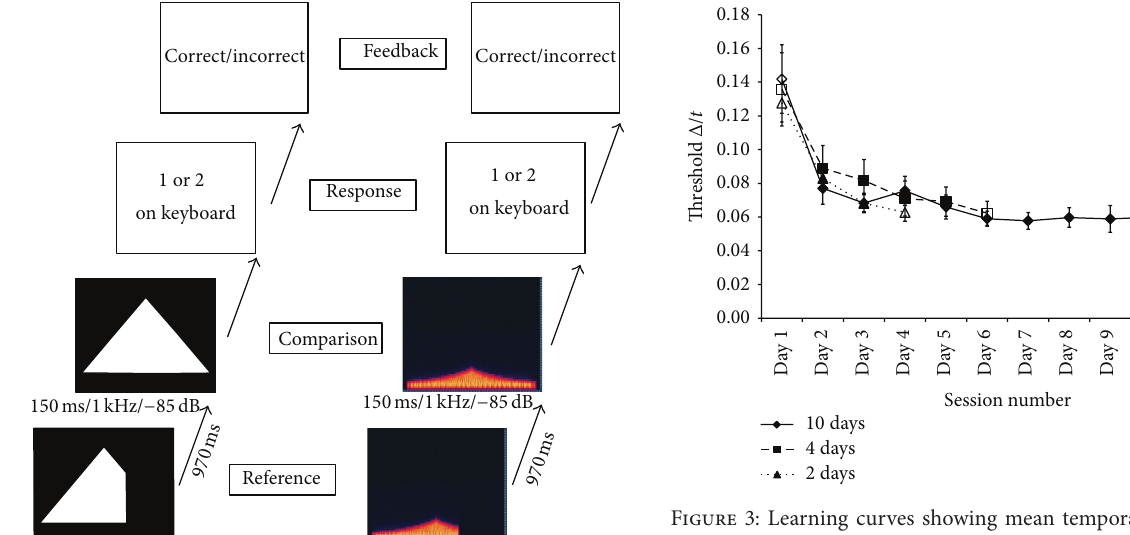
Figure 3: Learning curves showing mean temporal-duration dis- crimination ( Δ t / t for 79% correct performance) on the trained stan- dard interval (90ms/1kHz, −85 dB). Shapes on the lines represent experimental groups defined by number of training days ( Q = 10d, ◼ = 4d, 󳵳 = 2 d) with filled symbols showing pre- and posttest sessions. All other “days” are training days. Error bars indicate ± 1SEM. interaction (𝐹(2, 21) = 0.58, 𝑃 = 0.569, 𝑟 = 0.16)